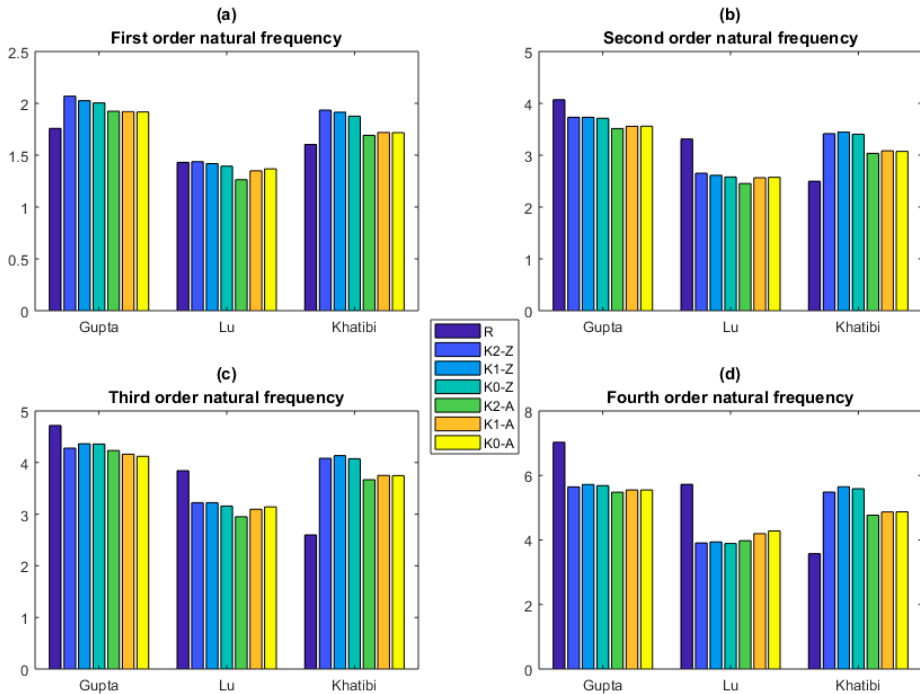
Figure 7. Comparison between the prediction results of KSM and that of MD (the units for the natural frequency is THz. K0–K2 are for constant, linear, and quadratic functions. Z and A are for Zigzag and Armchair graphene sheets, respectively. ( a ), ( b ), ( c ) and ( d ) are the first four order natural frequencies, respectively.).